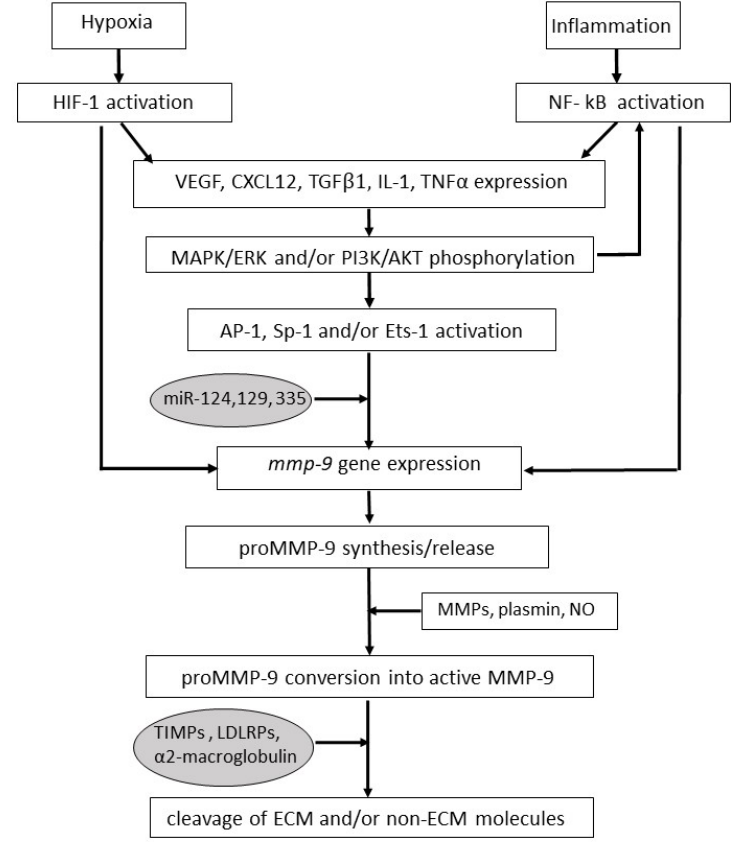
Figure 1. The MMP-9 pathway. In the rectangles, the main molecules and signaling pathways leading to MMP-9 expression or activation are shown; in the ellipses, the endogenous MMP-9 antagonists are listed. Arrows symbolize directions of connections. Abbreviations: AKT, protein kinase B; AP, activator protein; CXCL, CXC chemokine ligand; ECM, extracellular matrix; ERK, extracellular-signal-regulated kinase; HIF, hypoxia-inducible factor; IL, interleukin; LDLRP, low-density lipoprotein receptor-related protein; MAPK, mitogen-activated protein kinase; miR, microRNA; MMP, matrix metalloproteinase; NF-kB, nuclear factor-kappa B; NO, nitric oxide; PI3K, phosphoinositide 3 kinase; Sp, specificity protein; TGF, transforming growth factor; TIMP, tissue inhibitor of matrix metalloproteinase; TNF, tumor necrosis factor; VEGF, vascular endothelial growth